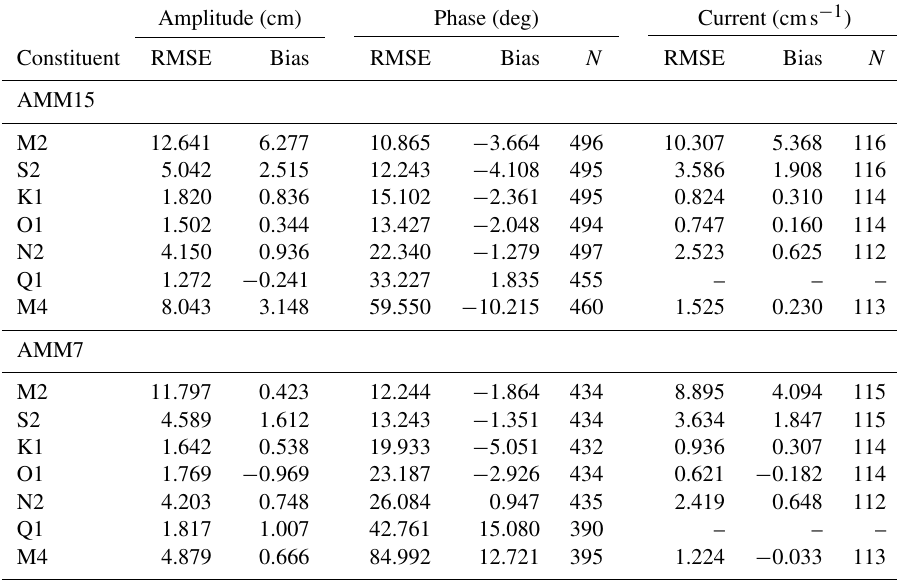
Table 1. Mean bias and RMS error (model minus observations) for amplitude and phase of major tidal constituents and the semi-major access of tidal currents. Observations are tide gauge data from National Oceanography Centre (NOC) Marine Data Products and the British Oceanographic Data Centre (BODC). Tidal current analysis uses the same data and method outlined in Guihou et al. (2017). The number of valid observations ( N ) is shown for each constituent comparison, depending on the observed variable and land-sea mask represented in each model